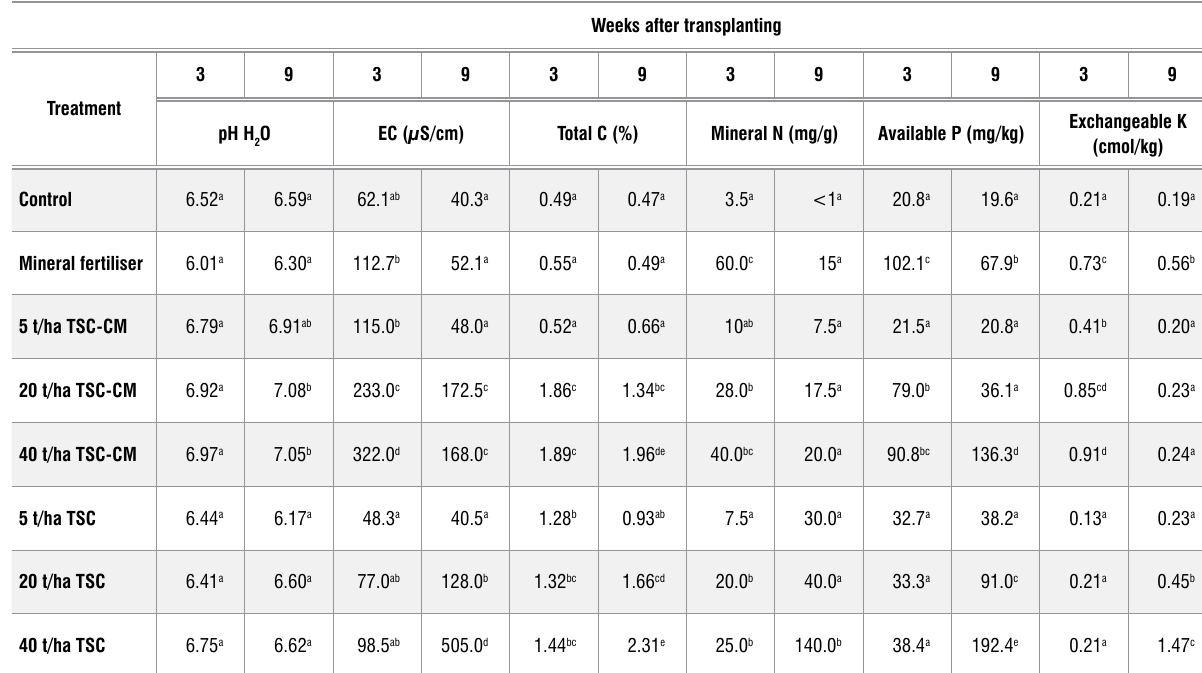
Selected soil chemical properties during growth of oilseed rape ( Brassica napus L.)